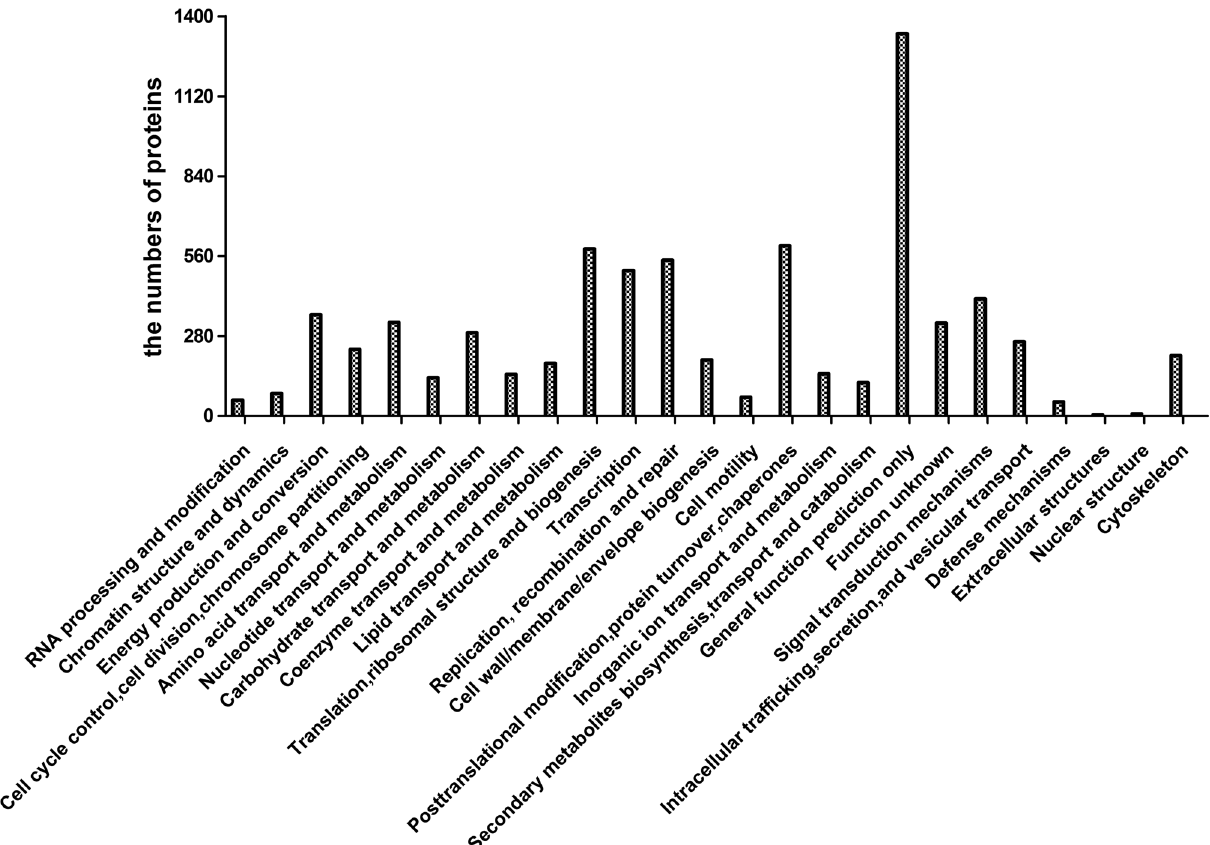
Figure 1. Gene ontology annotations of the proteome of BHK cells infected with Eimeria